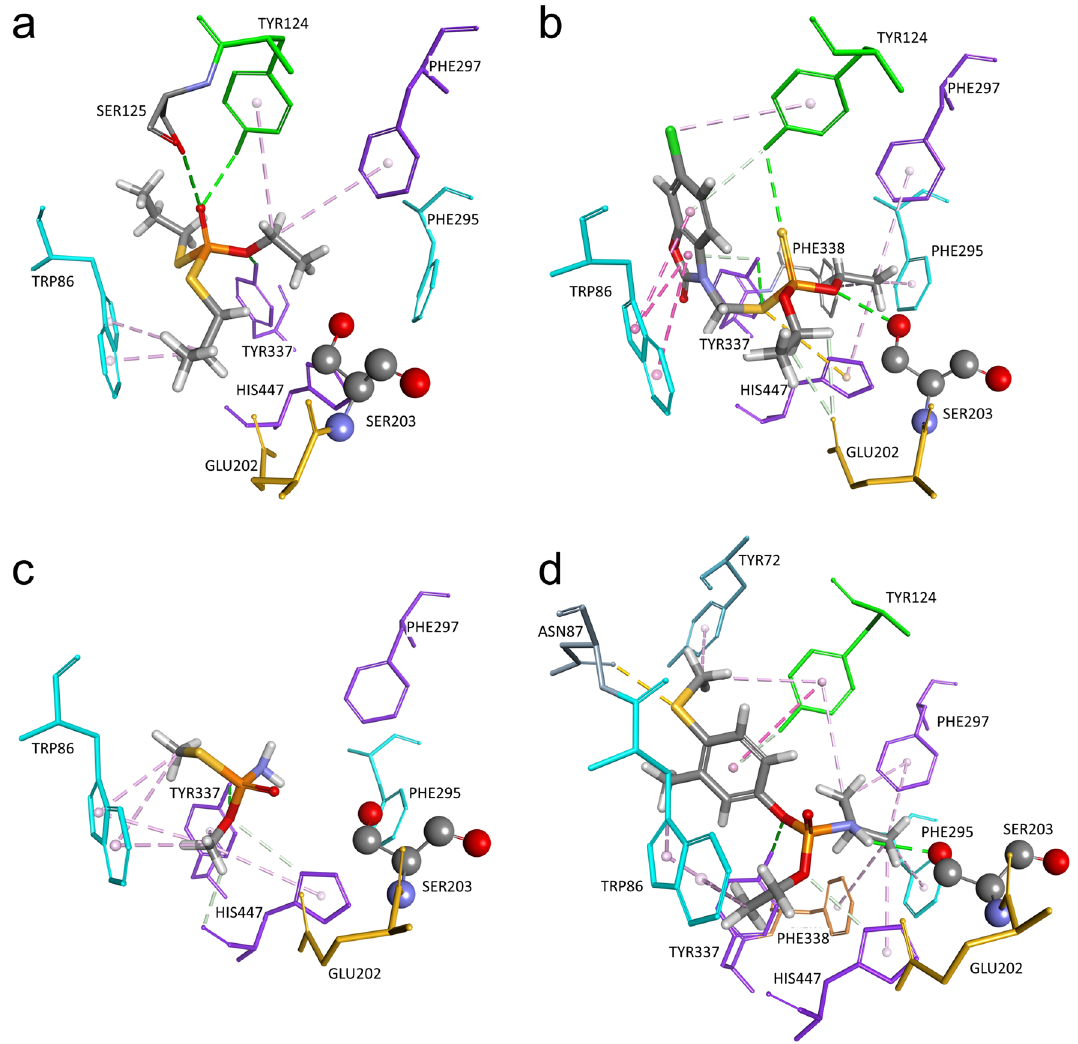
Figure 3. Model of Michaelis–Menten type complex of organophosphorus pesticides: ethoprophos ( a ), phosalone ( b ), methamidophos ( c ), and fenamiphos ( d ) within the active site of hAChE (PDB code: 4PQE 52 ). Poses were selected based on criteria that leaving group of pesticide is oriented opposite from the oxygen (Oγ) of catalytic serine (Ser203). Pesticide interactions are represented as dashed lines: hydrophobic (purple), hydrogen bonds (green) and electrostatic